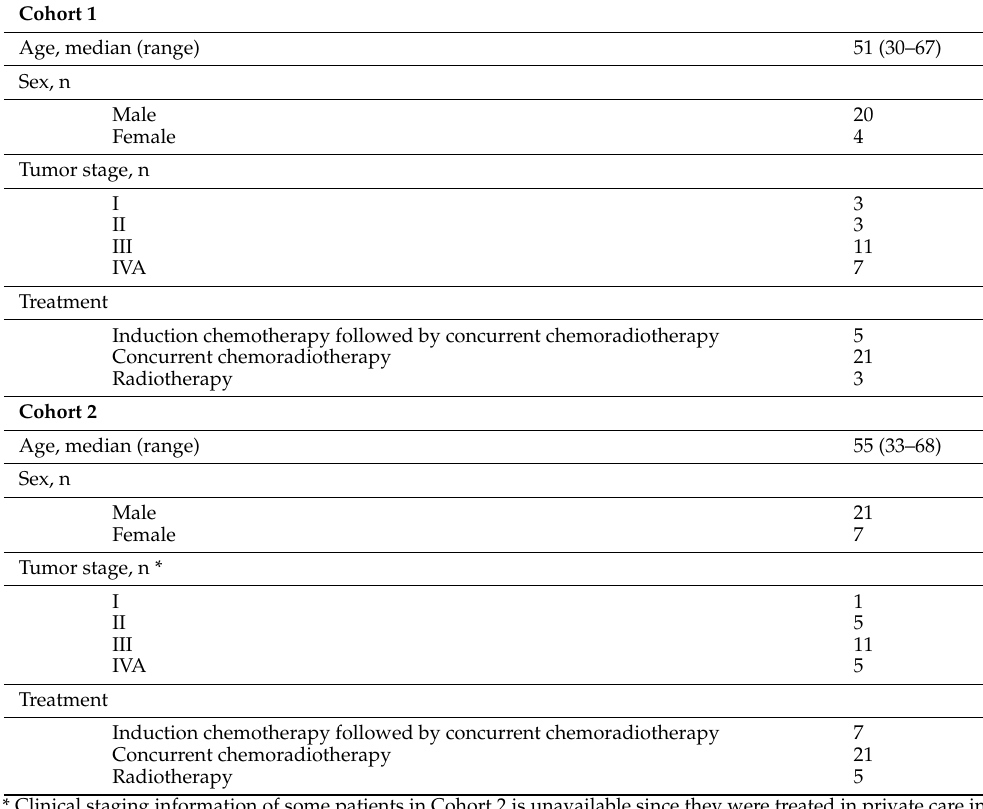
Table 1. Patient characteristics of cohorts 1 and